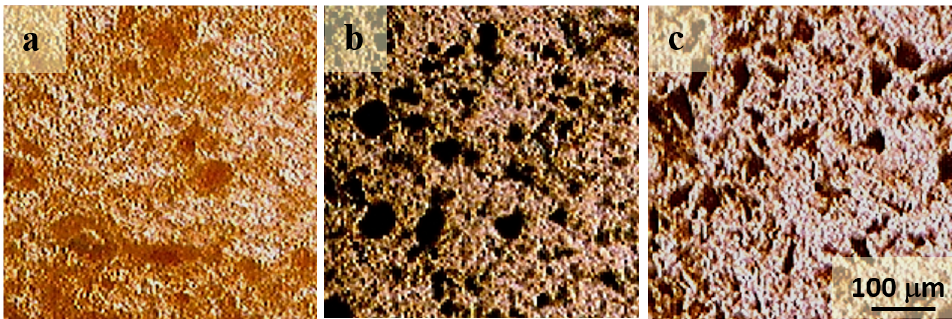
Figure 6. Optical micrographs of paraffin containing 5 wt. % asphaltenes ET ‐ A ( a ), ET ‐ Ox1 ( b ), ET ‐ Ox2 ( c ).